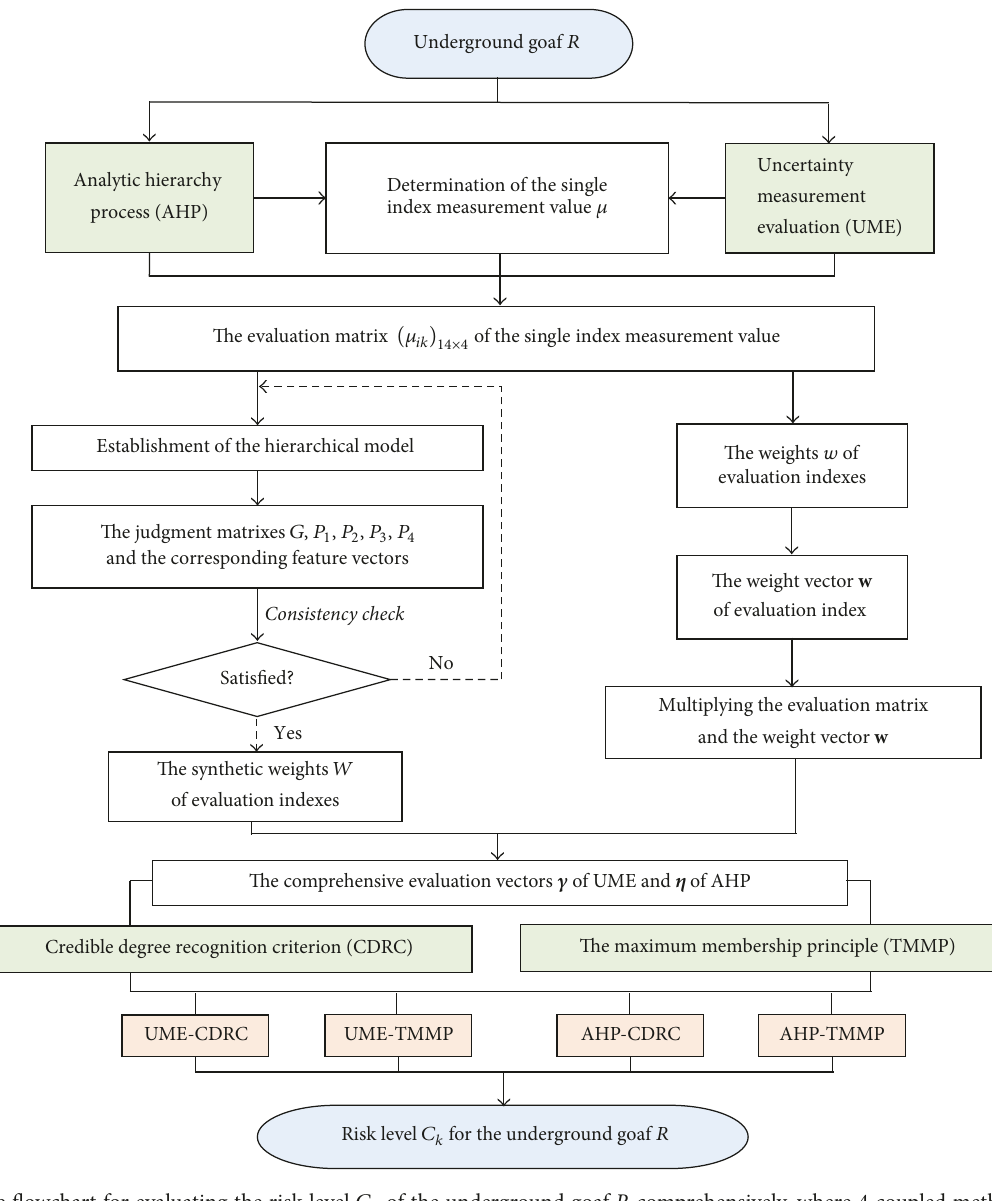
Figure 5: The flowchart for evaluating the risk level 𝐶 𝑘 of the underground goaf 𝑅 comprehensively, where 4 coupled methods including UME-CDRC, UME-TMMP, AHP-CDRC, and AHP-TMMP are applied.